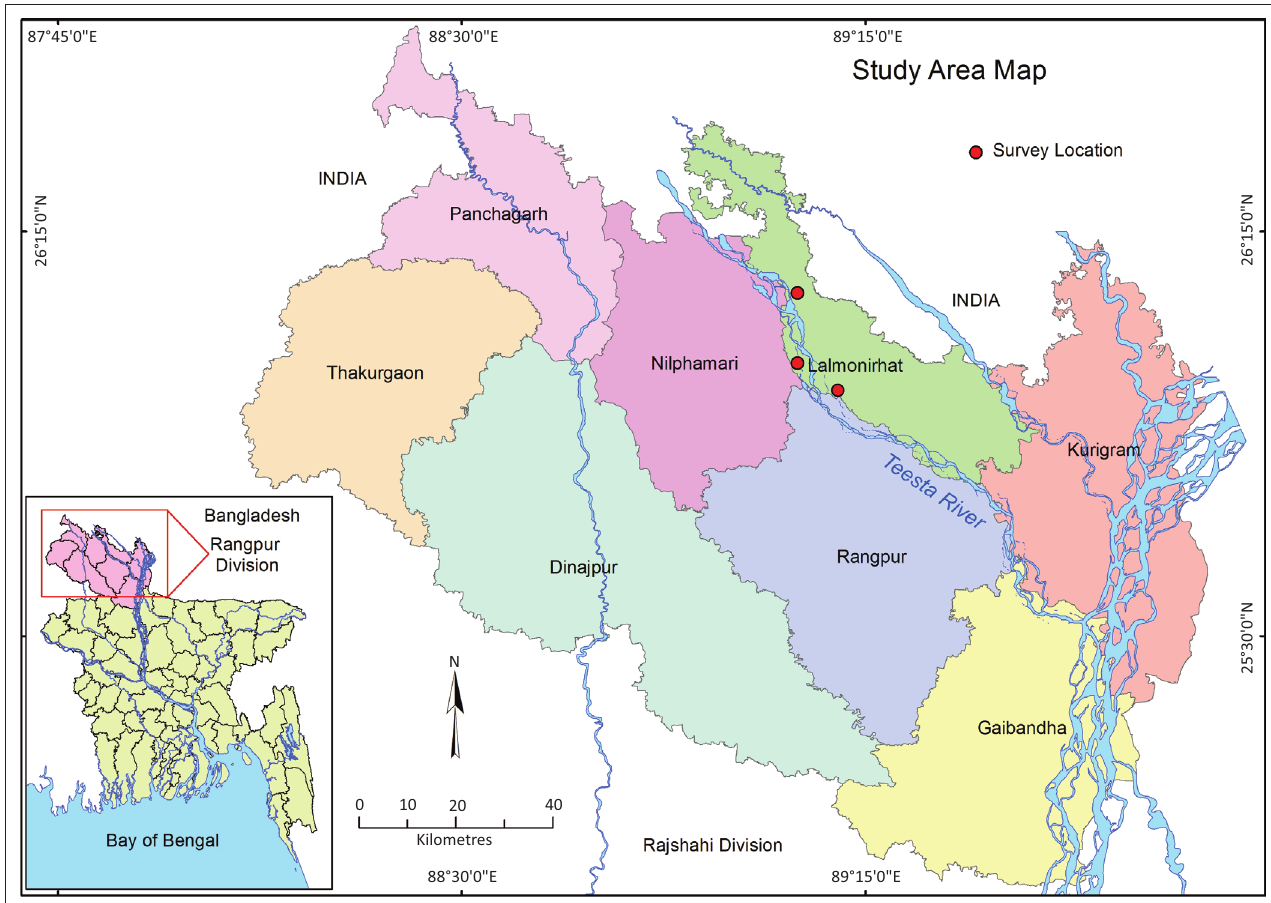
FIGURE 13: Map of the study